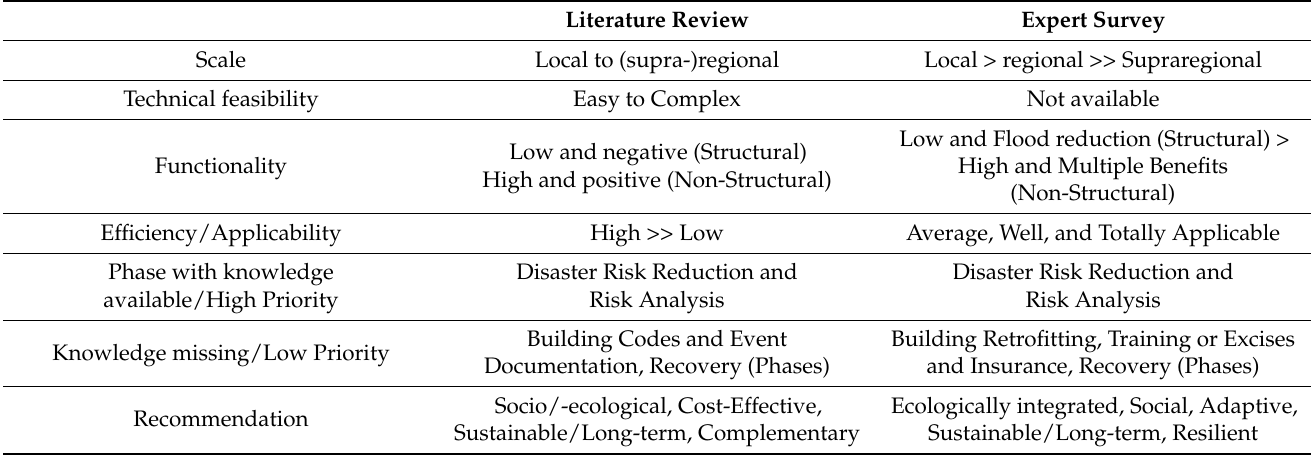
Table 6. Synthetic comparison between written and expert-based knowledge about flood management in rural mountain- ous